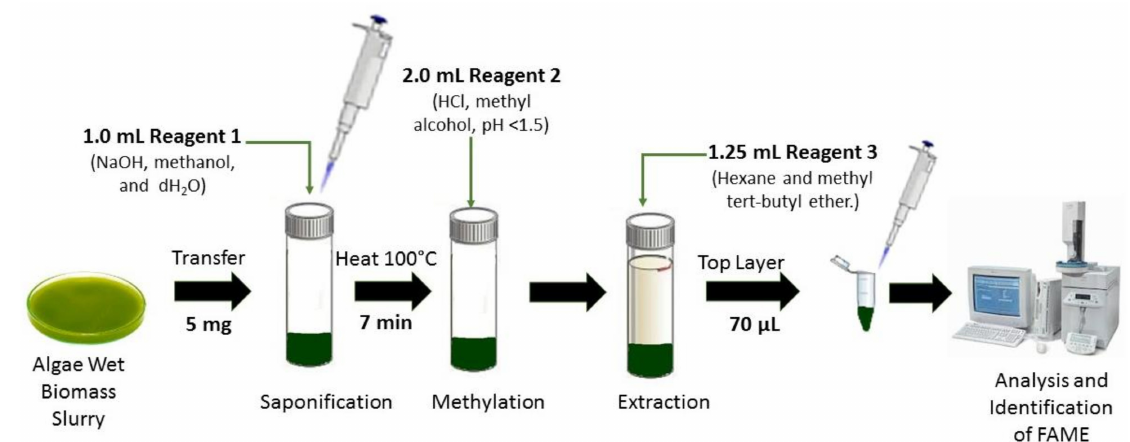
Figure 7. Microalgae fatty acids by Microbial Identification (MIDI)